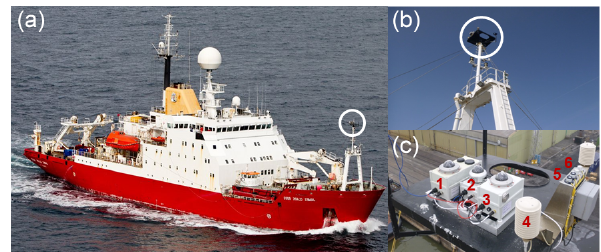
Figure 3. (a) RRS James Clark Ross showing the position of the foremast and instrument platform (circled). (b) The instrument plat- form (circled) viewed from below on the main deck. (c) Instruments in situ on the platform. (1) Spectrometer 1 – AS161; (2) SPN1; (3) Spectrometer 2 - Zeiss; (4) meteorological instrument solar radi- ation shield; (5) Kipp & Zonen PAR sensors (x2); (6) Kipp & Zonen pyranometers